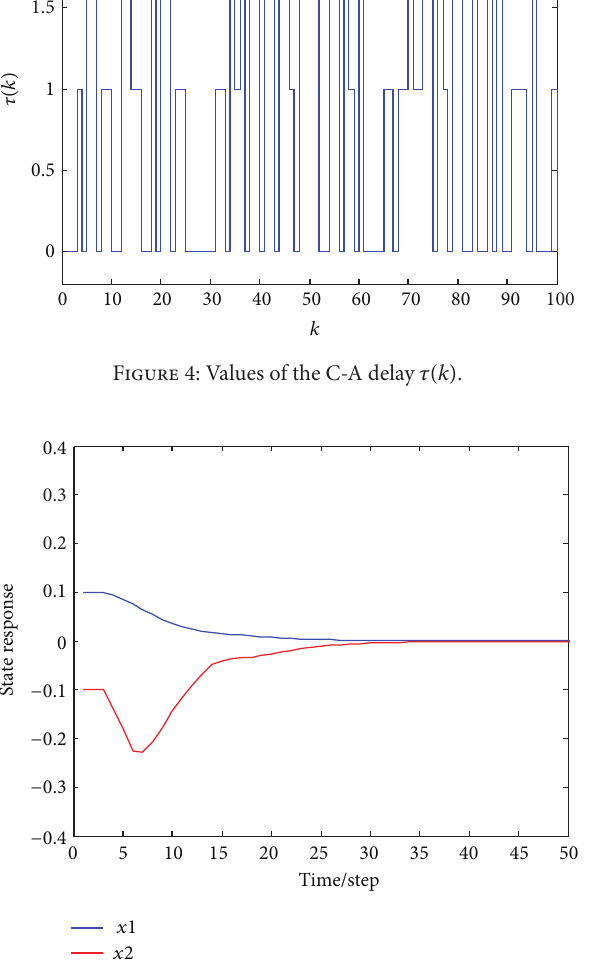
Figure 5: State trajectories under 𝐾